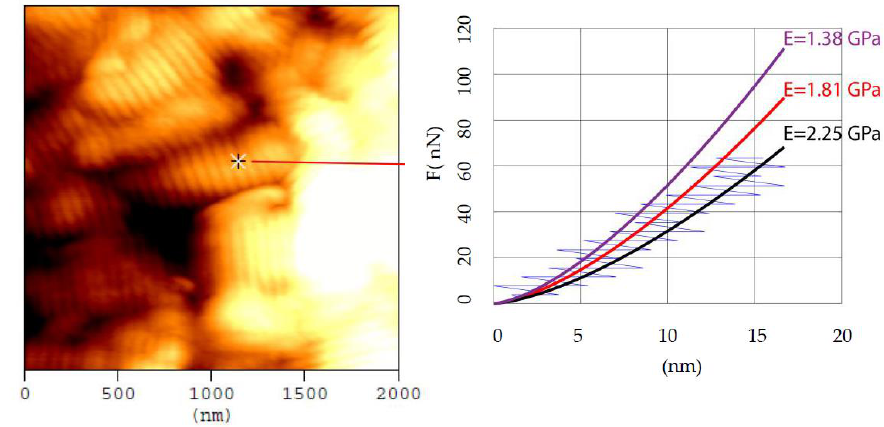
Figure 7. Obtaining a force–indentation curve on a collagen fibril. The protocol used for preparing the collagen type I, from bovine Achilles tendon, fibrils presented in the topography image is described in [25]. AFM experiments were conducted using a commercial microscope (CP II, Veeco Bruker, Santa Barbara, CA) in contact mode. For both imaging and indentation tests, pyramidal tips (MLCT tips constructed by Bruker) were employed. These tips have a nominal tip radius of approximately 20 nm on V-shaped cantilevers and a spring constant of 0.6 N/m. Three force–indentation curves on a collagen fibril with radius of ~200 nm were plotted. Depending on the range of data that will be used for processing, the Young’s modulus values vary significantly. The reason is that a collagen fibril is not a linear, elastic solid.